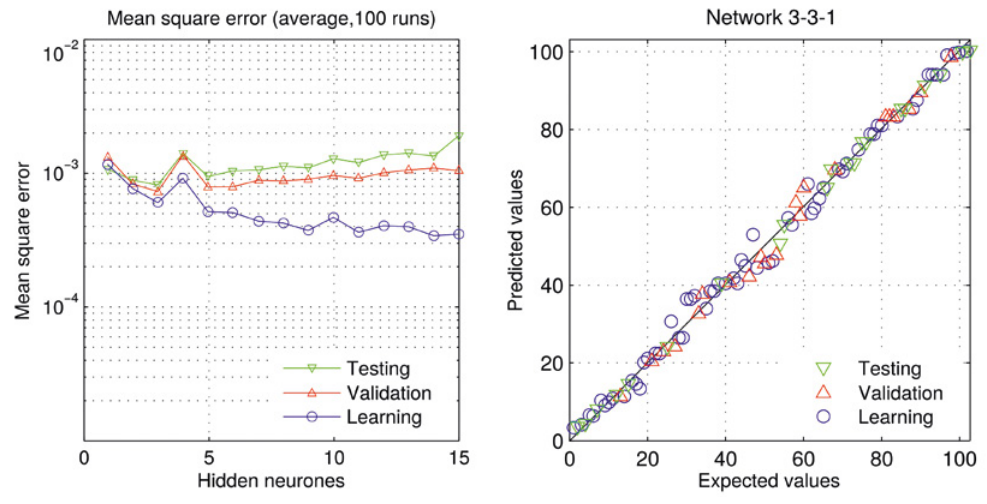
b) results of learning, Figure 4. Mean square error among reference positions in the ranking list